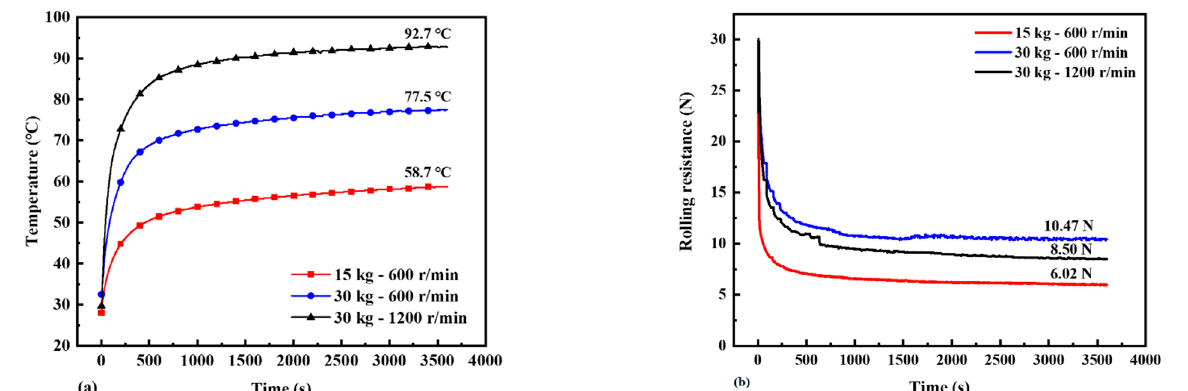
Figure 14. Steady-state surface temperature distribution of the solid tire recorded by an infrared camera under different boundary conditions ( a ) 15 kg and 600 rev/min, ( b ) 30 kg and 600 rev/min, ( c ) 30 kg and 1200 rev/min.